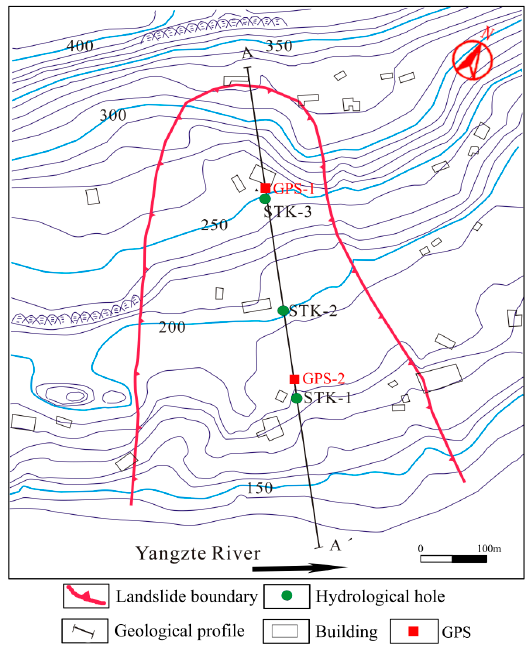
Figure 1. Topographical map of the Sifangbei landslide with the locations of monitoring points.